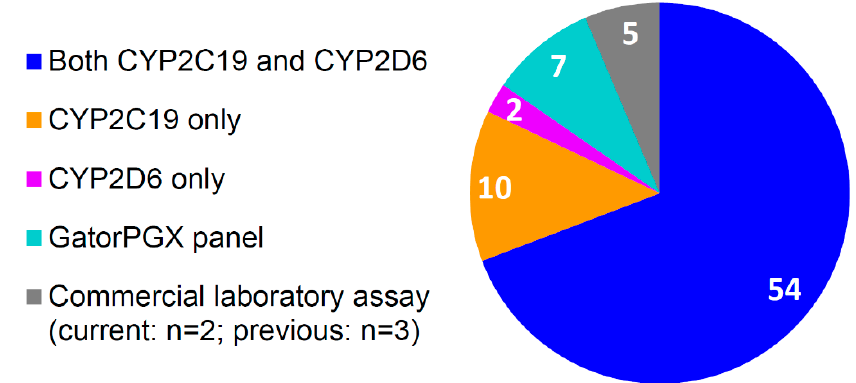
Figure 6. Number of patients (n = 78) with pharmacogenetic test results by gene / assay.